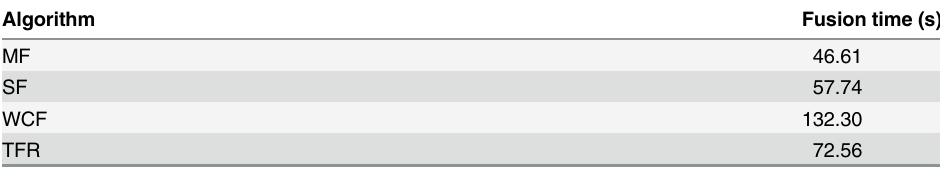
Table 3. Comparisons of fusion time among MF, SF, WCF and TFR of 5 targets. Algorithm